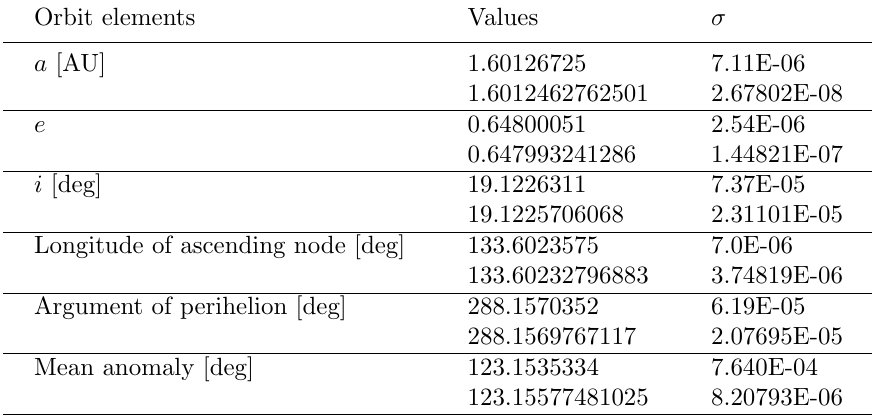
Table 4. Orbital elements and their 1 σ errors (rms) for (428694) 2008 OS9, calculated with the OrbFit software. Epoch: JD 2455000.5 TDT = 2009-06-18, rms = 0.519 (cid:48)(cid:48) both in our previous (top lines) and present (bottom lines) study.